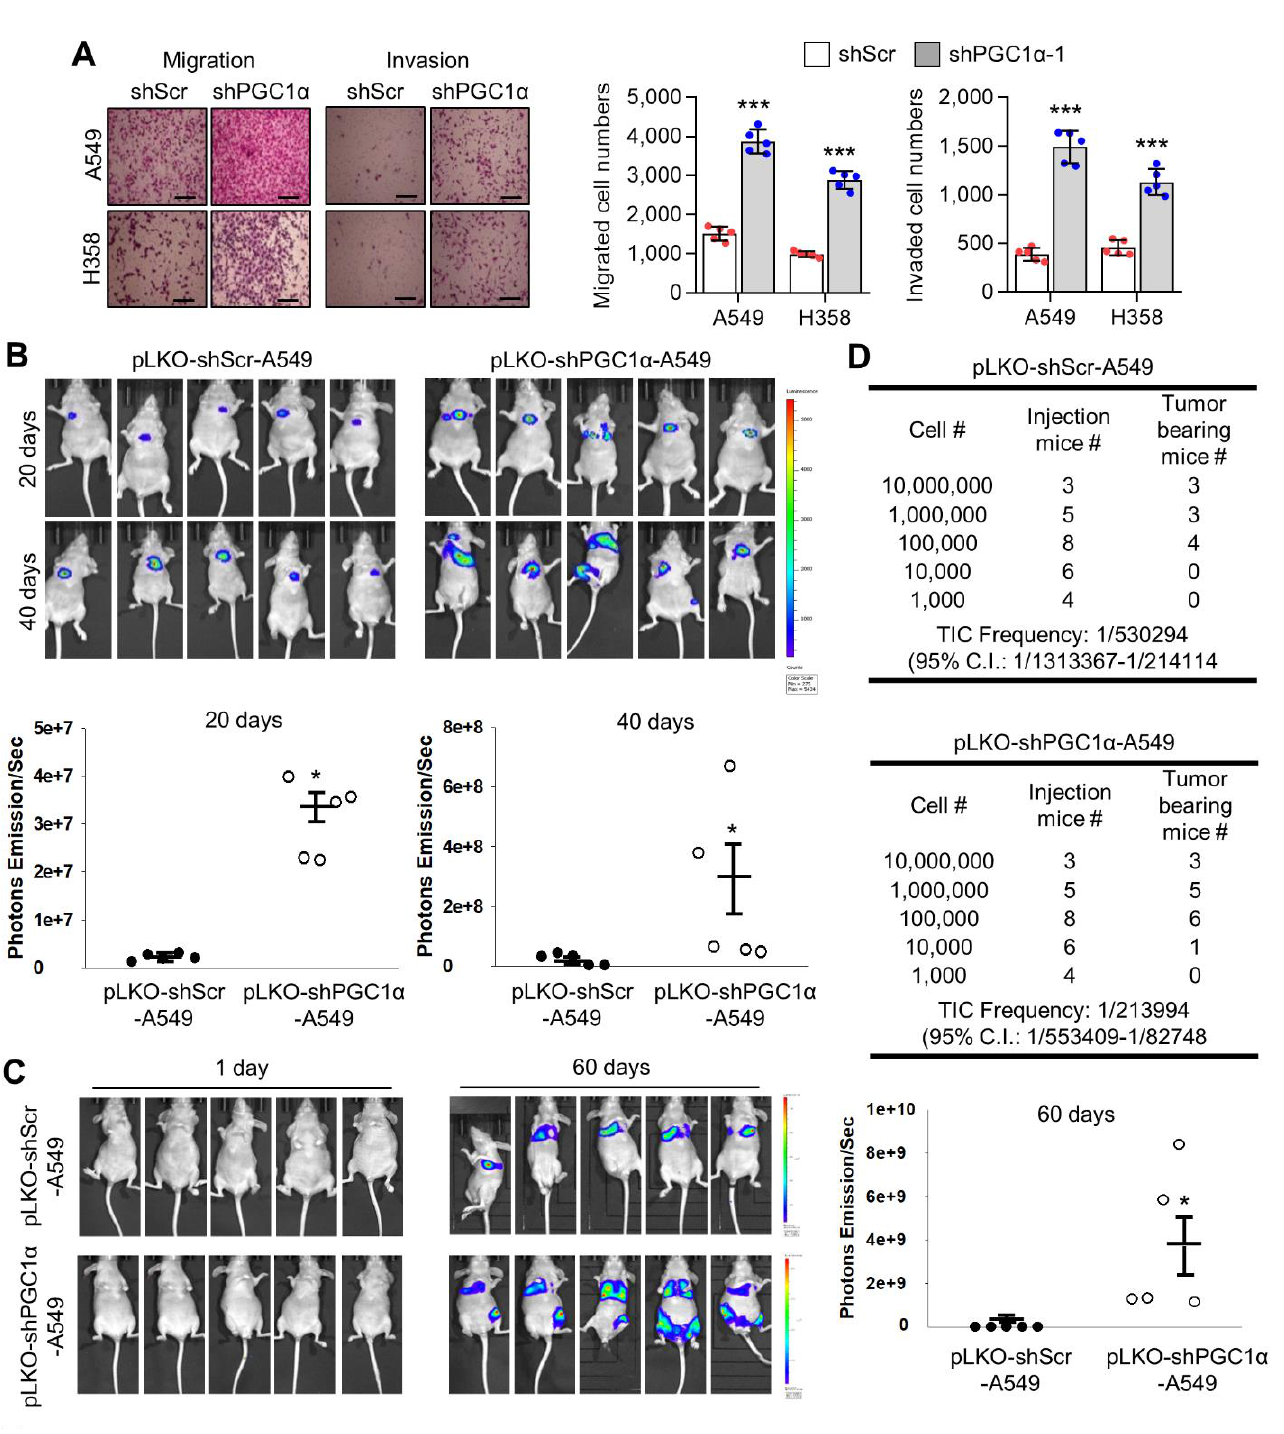
Figure 2. PGC1α loss promotes tumor initiation and lung cancer metastasis to bone. ( A ) Migrated and invaded cells in control and PGC1α-silenced A549 and H358 cells ( n = 5). Scale bar represents 200 μm. High Resolution Images are showed in Figure S8. ( B , C ) Luciferase images from control or PGC1α-silenced A549 cells xenografted mice ( n = 5) by intratracheal ( B ) and tail-vein ( C ) injection. Luciferase images represent one picture captured and the values of photons emission are